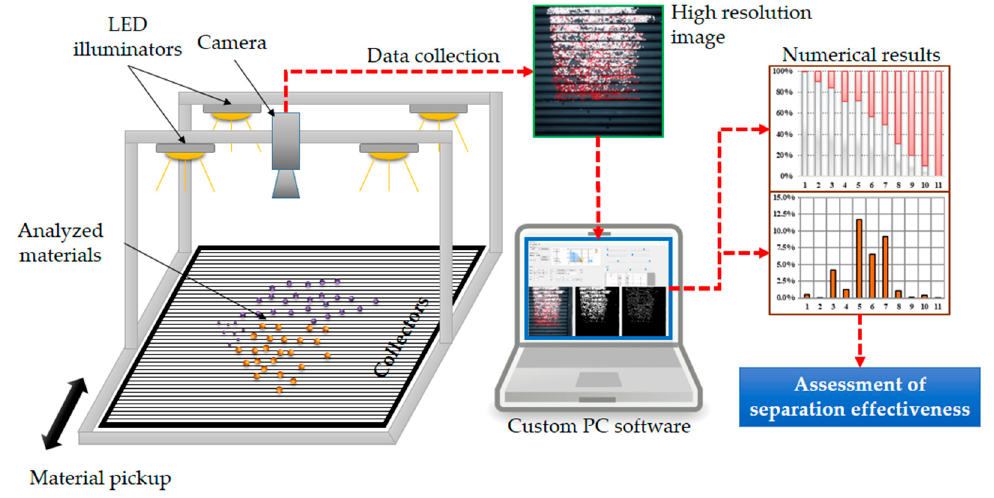
Figure 2. Concept of the vision system for the assessment of ES effectiveness.